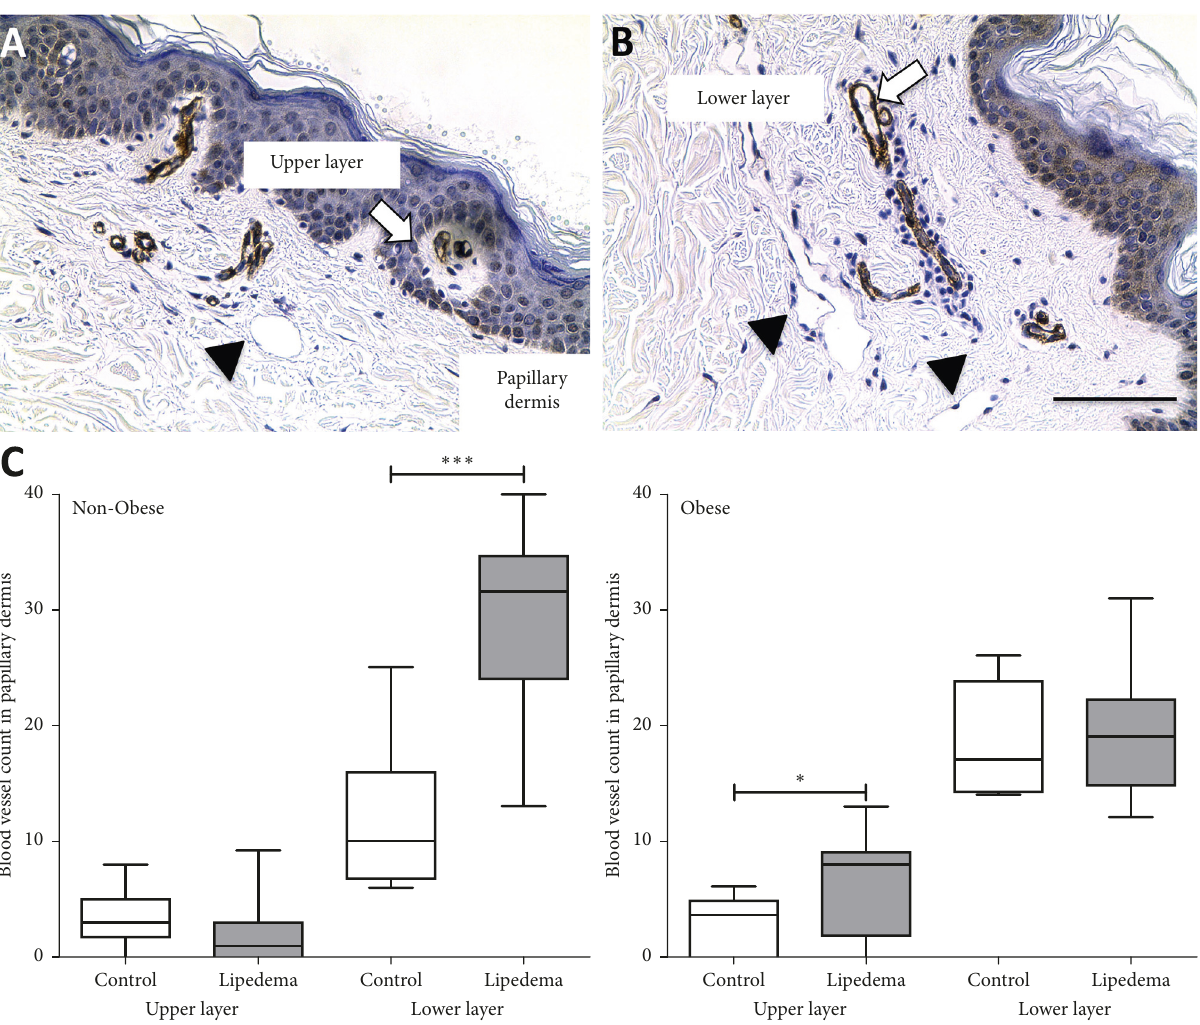
Figure 3: Number of blood vessels counted in the thigh skin of Non-Obese and Obese participants with and without lipedema (controls). (A, B) Immunohistochemistry of smooth muscle actin (SMA) positive vessels in the papillary dermal layer of lipedema leg skin (arrows). Note large lymphatic vessels in B (arrowheads) (scale bar 100 µ m). (C) Box and whisker plots representing the blood vessel count in groups. Non-Obese group (Control n 10; Lipedema n 13); Obese group (Control n 8, Lipedema n 15). (cid:31) (cid:31) (cid:31) (cid:31)